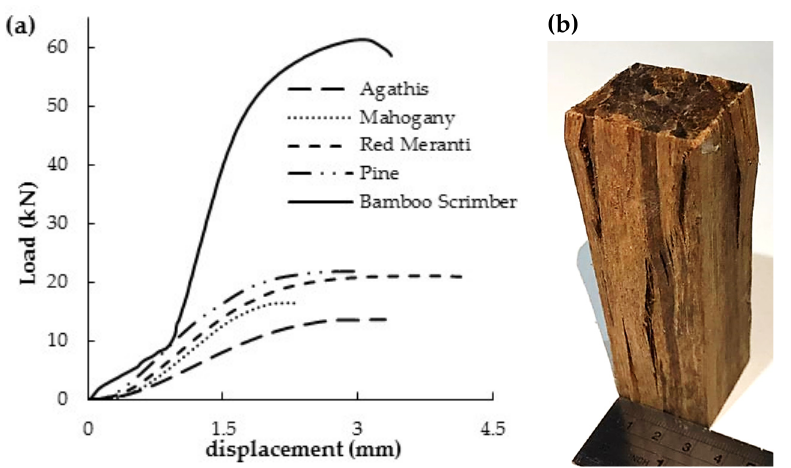
Figure 6. Compression parallel-to-fiber ( a ) results and ( b ) specimen failures in